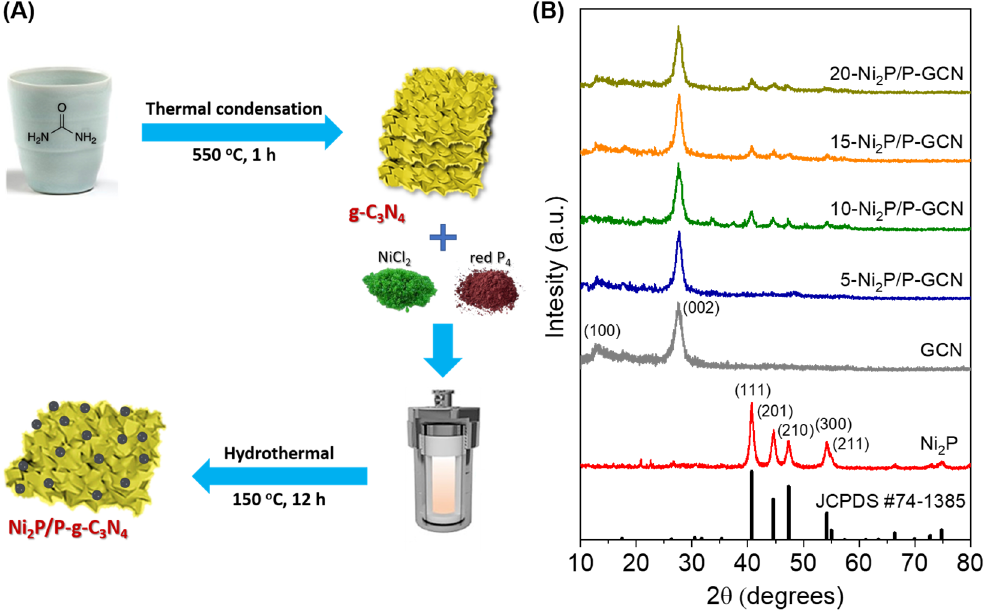
Figure 1. ( A ) Schematic display of the synthetic procedure of Ni 2 P-modified P-doped g-C 3 N 4 (Ni 2 P/P-GCN) heterostructures. ( B ) Typical XRD patterns of Ni 2 P, GCN and Ni 2 P/P-GCN materials.